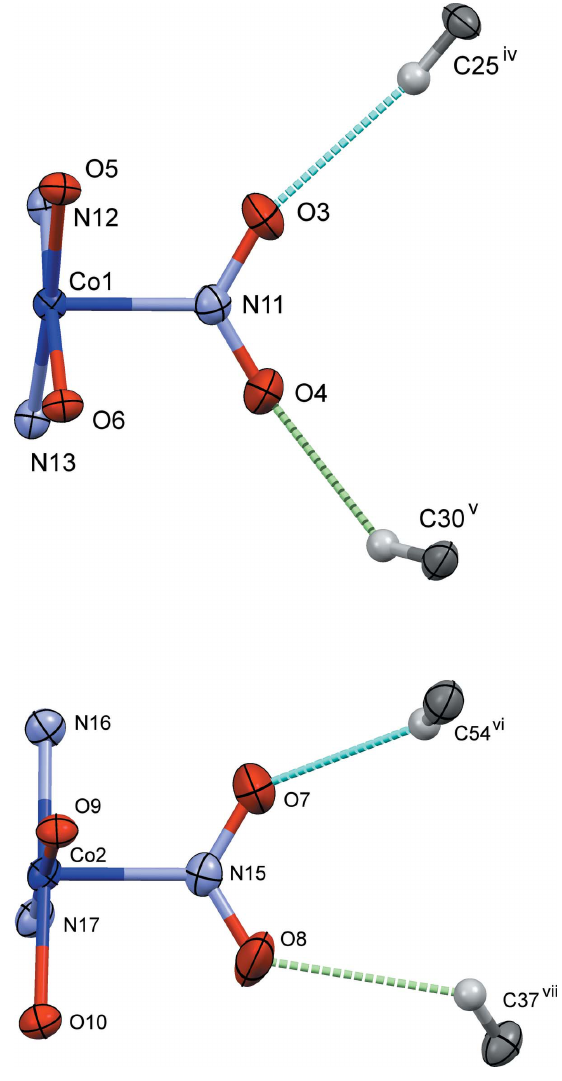
Figure 6 The steric circumstances of the nitro groups in (I). Only parts of the complex are shown for clarity. The C—H (cid:2)(cid:2)(cid:2) O hydrogen bonds are shown as blue dashed lines. The green dashed lines indicate other O (cid:2)(cid:2)(cid:2) H contacts shorter than 2.8 A˚ , O4 (cid:2)(cid:2)(cid:2) H30 v = 2.77 A˚ and O8 (cid:2)(cid:2)(cid:2) H37 vii = 2.66 A˚ . Symmetry codes: (i) x + 1 , (cid:3) y + 3 , (cid:3) z + 1; (ii) x + 1, y , z ; (iii) (cid:3) x , 2 2 y + 1 , (cid:3) z + 1 ; (iv) x (cid:3) 1 , (cid:3) y + 3 , (cid:3) z + 1; (v) x (cid:3) 1 , (cid:3) y + 1 , (cid:3) z + 1; (vi) (cid:3) x , 2 2 2 2 2 2 y (cid:3) 1 , (cid:3) z + 1 ;; (vii) (cid:3) x + 1, y (cid:3) 1 , (cid:3) z + 1 . 2 2 2 2 (cid:3) group in its plane will be blocked by the rotation of the NO 2 C—H (cid:2) (cid:2) (cid:2) O hydrogen bonds. The steric condition of O7— N15—O8 in (I) is similar to that in (II), suggesting that the